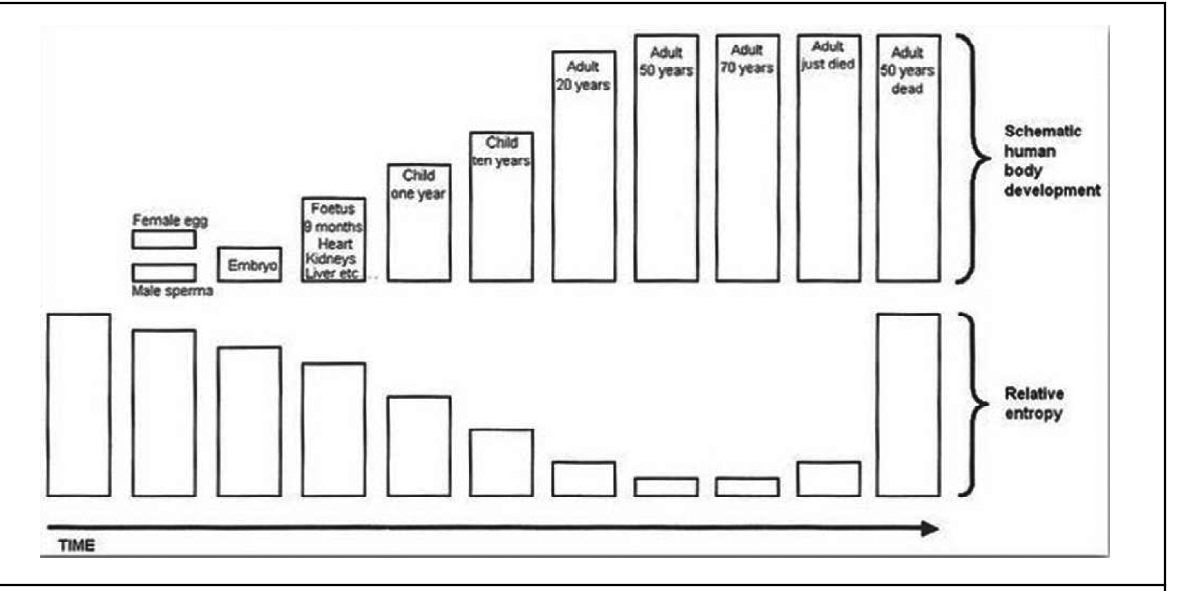
Figure 2: Danish chemist John Schmitz’s (2007) “relative entropy of a human”, i.e., “human entropy” diagram, in which he seems to conceptualize the notion that a person’s level of entropy is the lowest (low entropy) in his/her last decade of existence, prior to death (de-reaction), which means that an adult person in aged 50 to 70, after which 50-years later, following decomposition, a person’s so-called afterlife entropy is as high (high entropy) as it was before his/her birth (reaction synthesis).